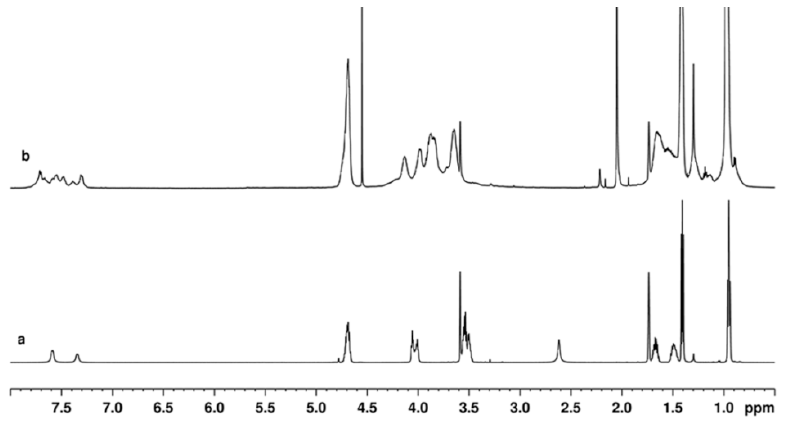
Figure 7. 1 Н NMR spectra of: ( a ) pure ligand 5 in THF-d 8 , and ( b ) mixture of 5 and BH 3 •SMe 2 in THF-d 8 .